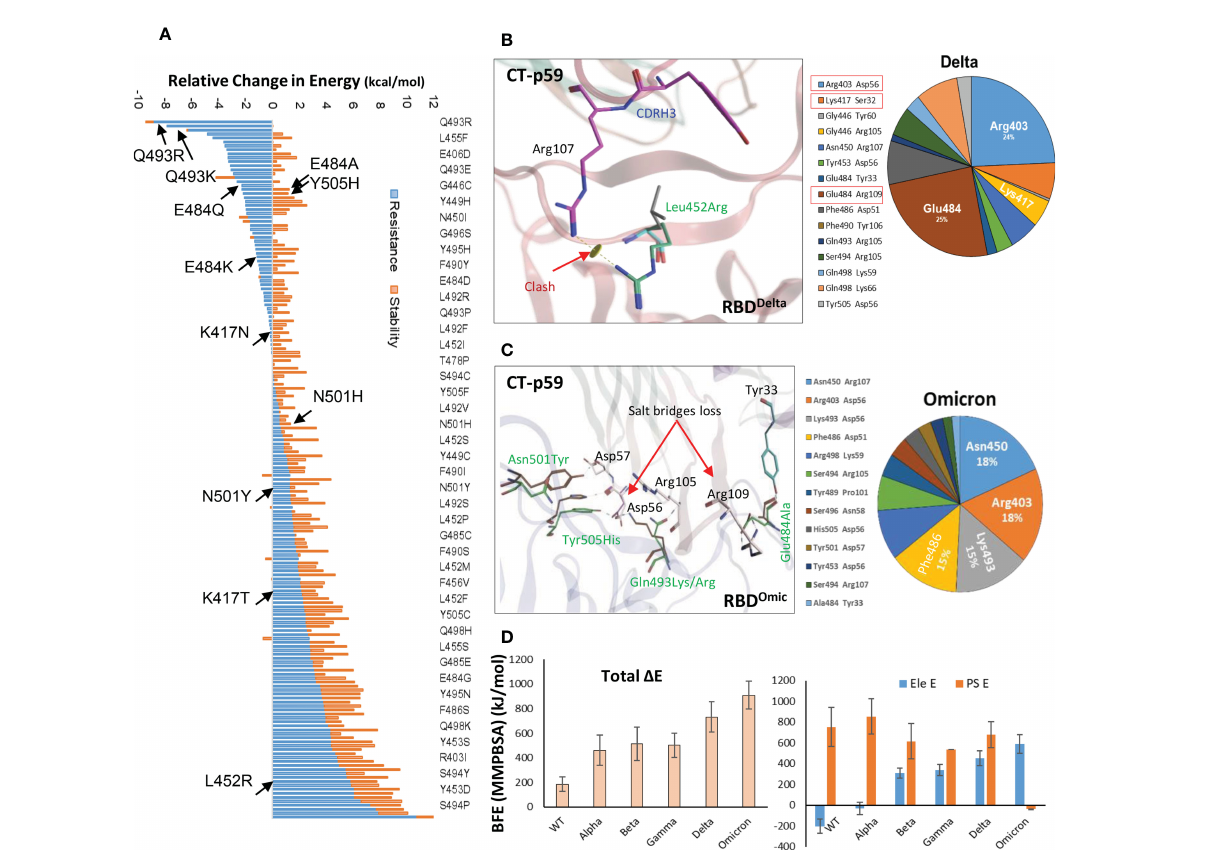
FIGURE 2 Immune escape and escape prediction of the SARS-CoV-2 VOCs. (A) SARS-CoV-2 immune escape prediction concerning CT-p59. The amino acid list on the right is shortened for clarity; af fi nity and stability changes for each of 176 residues corresponding to fi gure 2A are listed in Table S3. Amino acids and their respective substitutions involved in ACE2 and CT-p59 binding are labeled and indicated with black arrows. Blue bars indicate resistance to CT-p59, where negative values indicate increase in mAb-binding af fi nity and positive value indicate increase in mAb-escape or loss in af fi nity. Orange bars indicate stability in Ag-Ag complex. (B) Leu452Arg mutation in Delta VOC abolishes the electrostatic contacts between CDRH3 and RBD Delta . The pie chart represents the energy contribution (in percentage, unit is kcal/mol) at the RBD Delta -CT-p59 interface. (C) Glu484Ala mutation in RBD Omicron abolishes the salt bridge between CDRH3 and RBD. The pie chart represents the energy contribution at the RBD Omicron - Etesevimab interface. Changes in the Interface contacts along with their bonds-length, bonds-energies and bonds-type of CT-p59 bound to WT, Delta ad Omicron variants, corresponding to fi gure 2A and C are listed in Table S1. (D) Free energy perturbation of the CT-p59-RBD complexes of all SARS-CoV-2 VOCs. Wild type and Alpha strains retain their electrostatic energy while other VOCs completely lost this